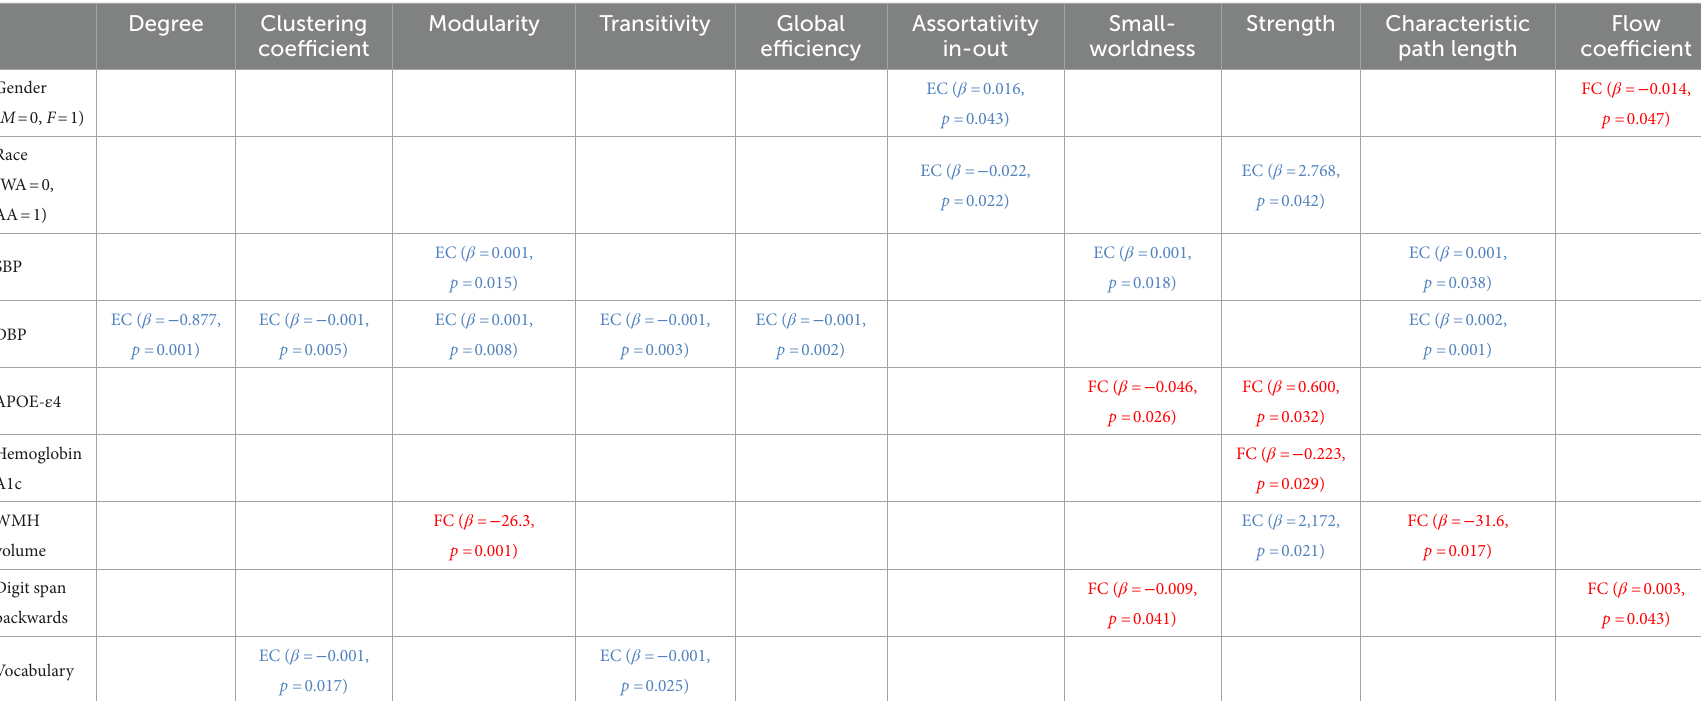
TABLE 3 Linear relationships between demographic, cardiometabolic, and cognitive measures and graph metrics derived from EC and FC for Stroop task